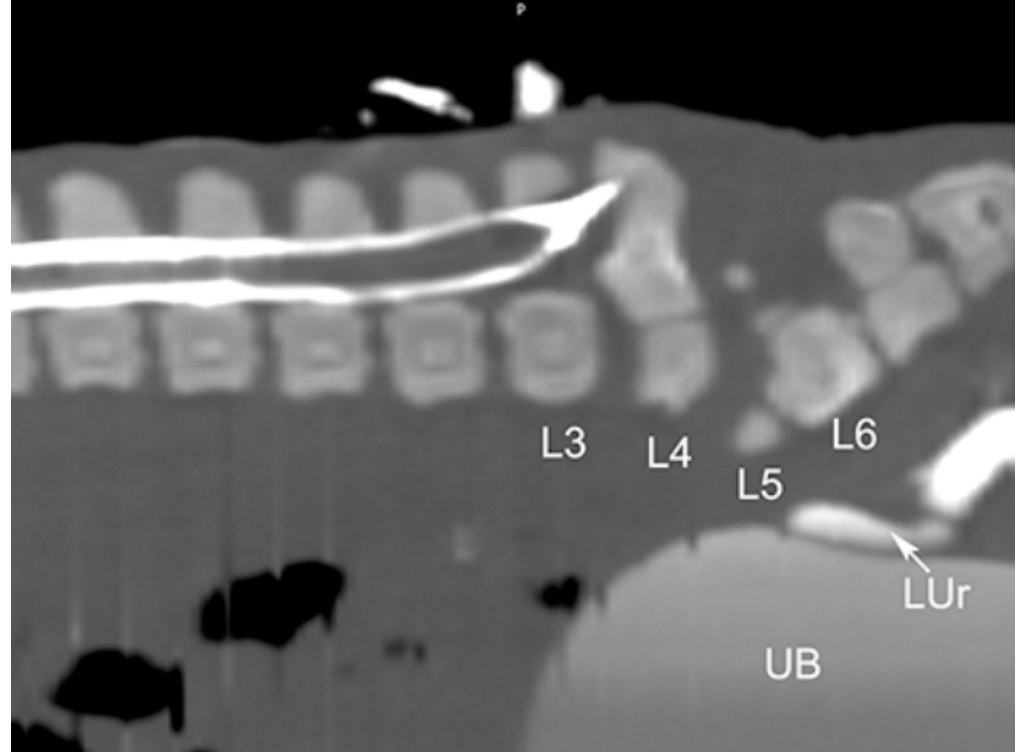
Figure 3. CT-myelography of the Piglet #1; sagittal multiplanar reconstruction (MPR) of the lumbar tract. The dural sac stops at the level of L3–L4 and is dorsally directed, ending in the soft tissue between a L4 bisected dorsal process (not visible in this scan plan). The lesion is compatible with myelomeniongocele and spina bifida. The affected lumbar vertebrae show the radiographic features described in Figure 2. Legend: L3–L6 = lumbar vertebrae; LUr = left ureter; UB = urinary bladder.